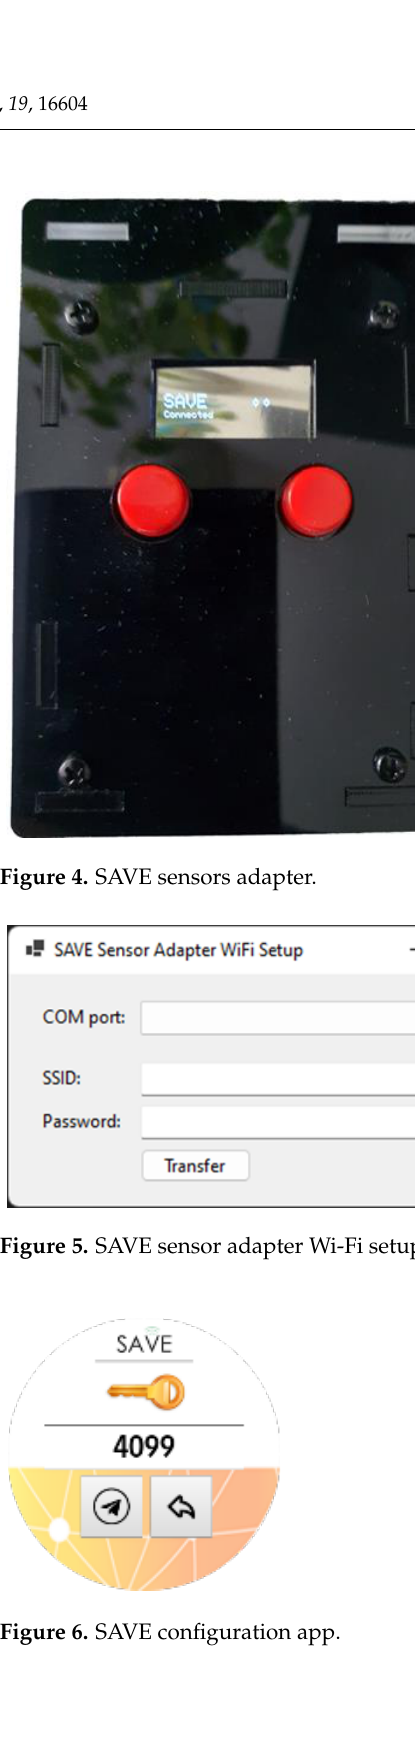
Figure 7. SAVE watch face.